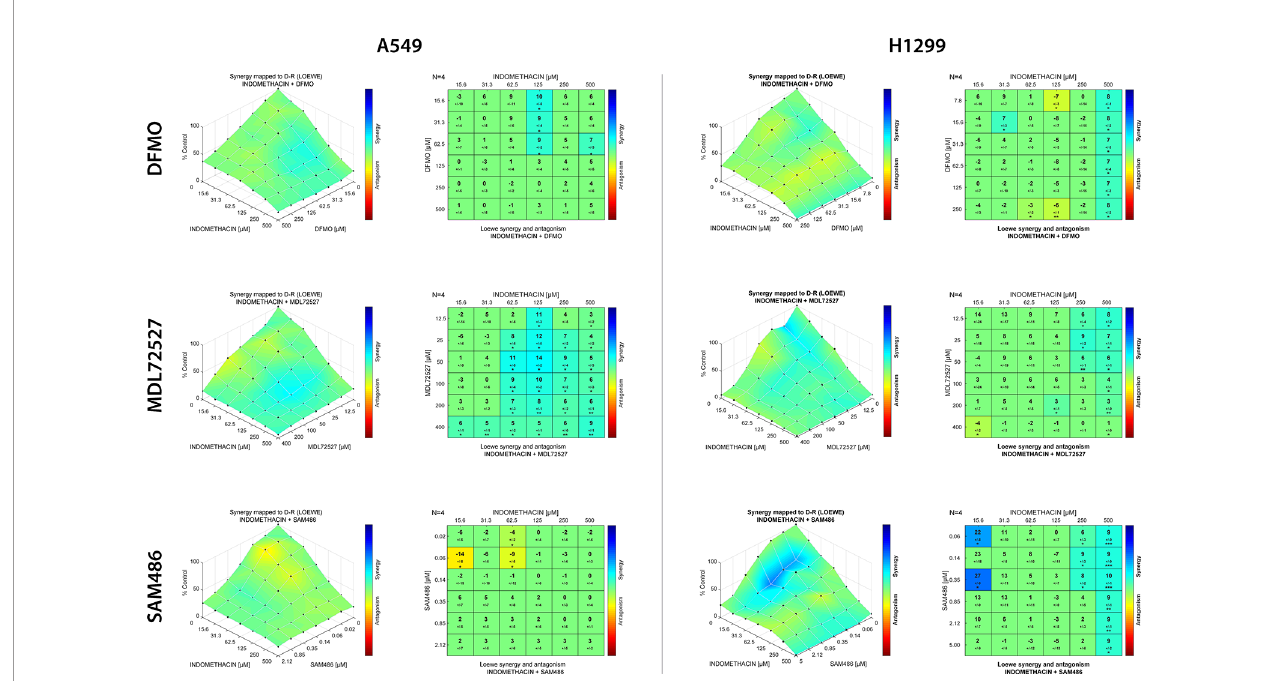
FIGURE 6 | Effect of indomethacin combined with e fl ornithine (DFMO), SAM486A, and MDL72527 on the viability of non-small cell lung cancer (NSCLC) cells. The effects of the combination of indomethacin with DFMO (upper row), MDL72527 (middle row), and SAM486A (lower row) on cell viability were measured using the 3- (4,5-dimethylthiazol-2-yl)-2,5-diphenyltetrazolium bromide (MTT) assay in two NSCLC cell lines: A549 (left panels) and H1299 (right panels). Cells were exposed to the different drugs for 96 h. For the drug combinations, two-fold dilution series comprising six concentrations, were mixed in every possible combination. Effects matrices were plotted using the Combene fi t software. This software constructs a XYZ model of the combination, using the effect of each drug alone and Loewe ’ s model of drug additivity. Differences between the theoretical combinations and empirical data are represented by a number generated for each combination point. Positive numbers represent synergistic combinations, whereas negative numbers indicate antagonistic interactions. The color code shows combination points that are signi fi cantly different from the theoretical model, calculated using Student ’ s t-test. * p < 0.05, ** p < 0.01, and *** p < 0.001. The graphs show the mean ± standard deviation of four independent